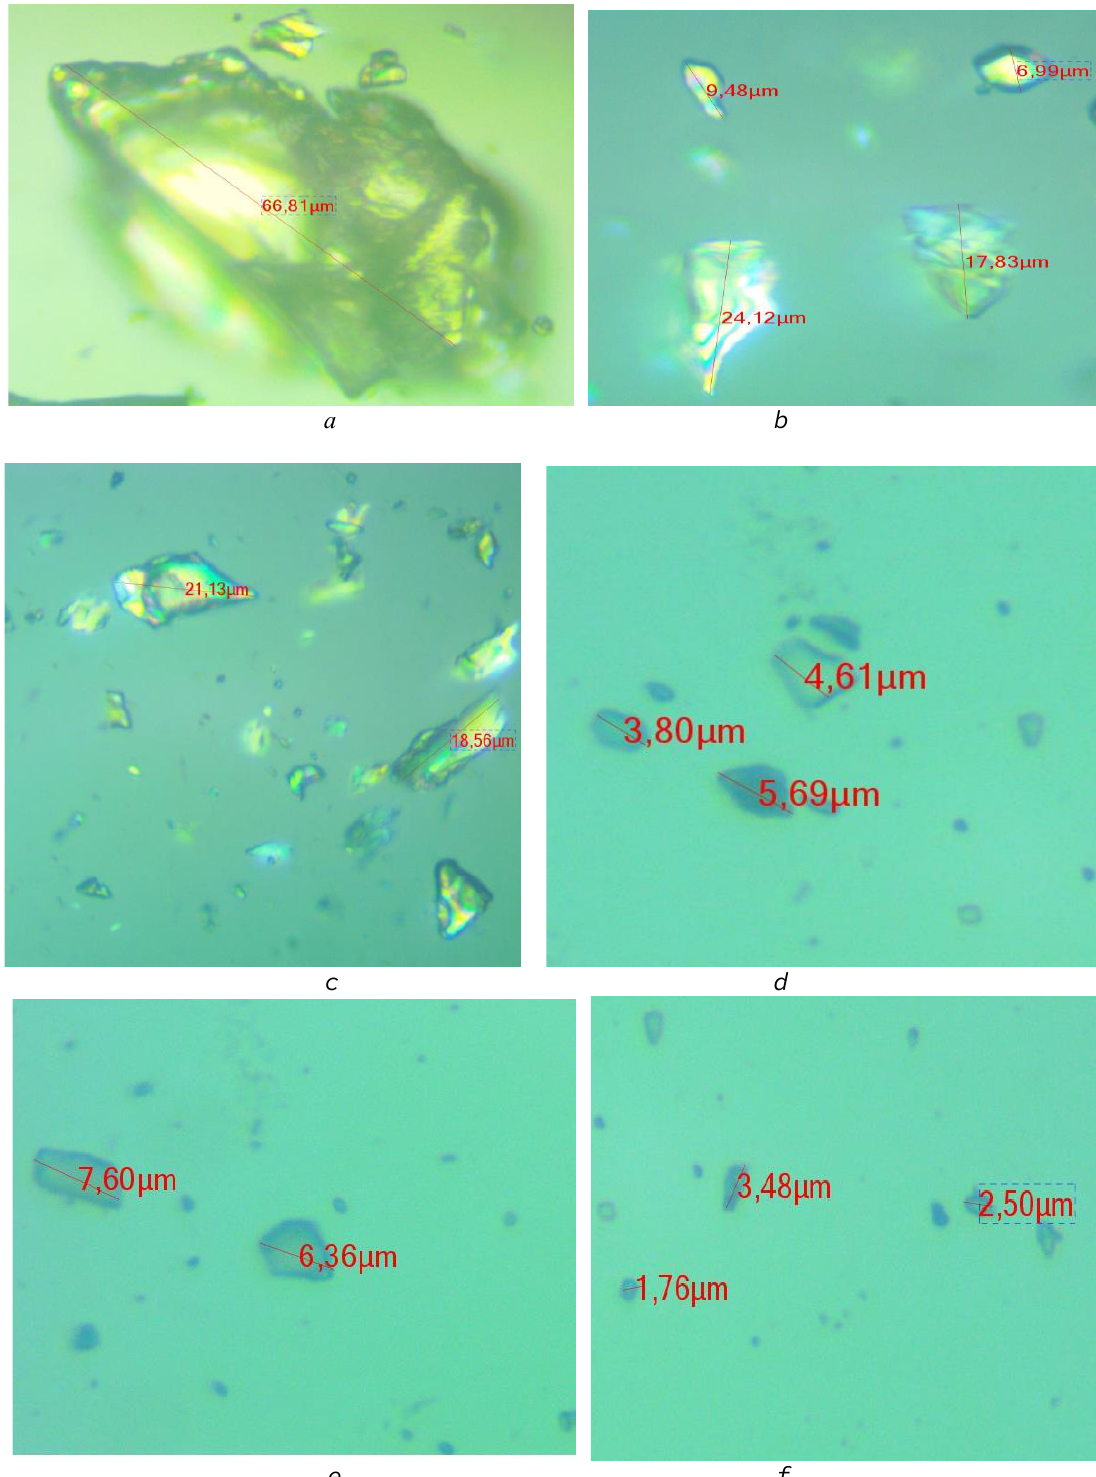
Fig. 3 Micrographs of gel samples obtained from different homogenization parameters: а – sample 1; b – sample 2; c – sample 3; d – sample 4; e – sample 5; f – sample